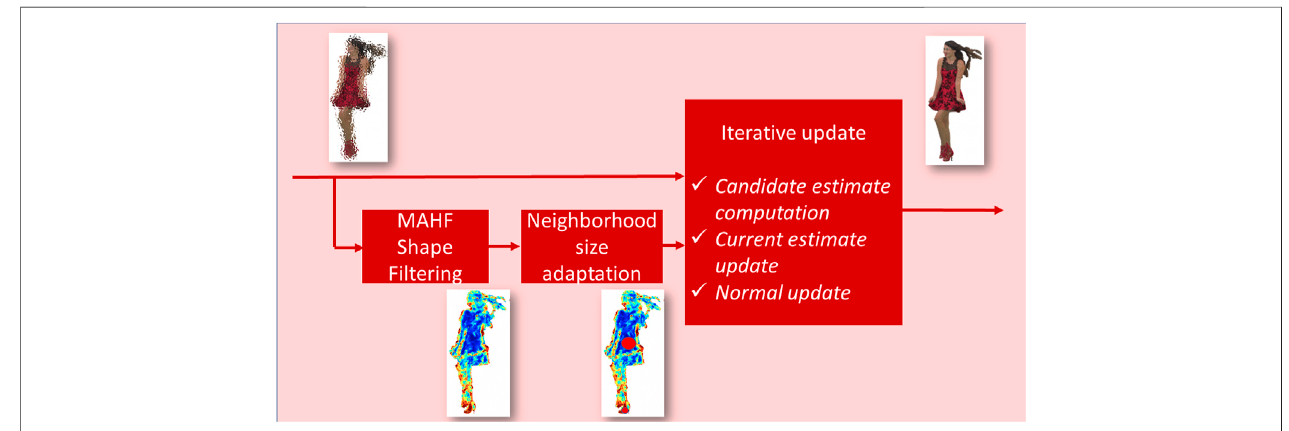
FIGURE 6 | VIPDA overview.